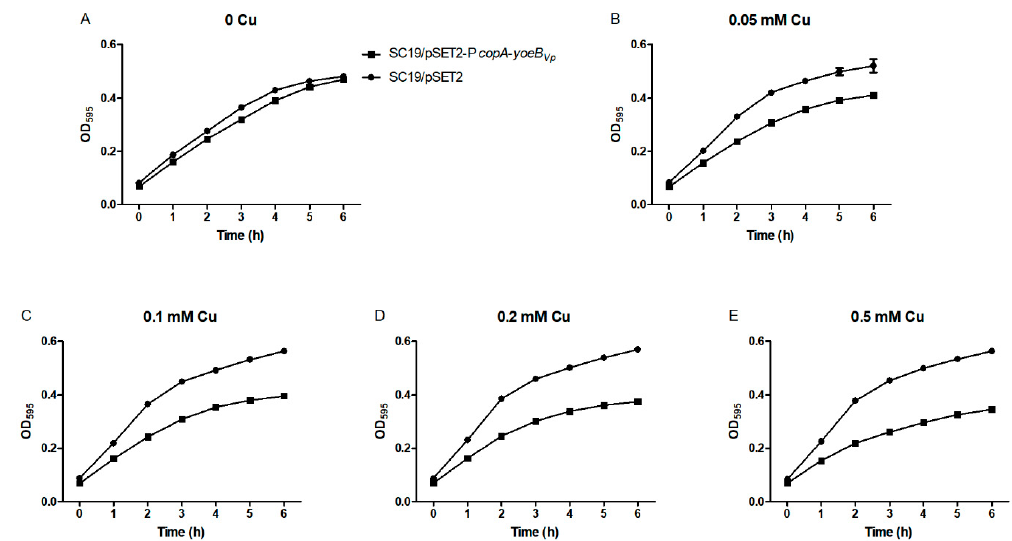
Figure 2. YoeB Vp expression resulted in a growth defect in S. suis in liquid media. The SC19/pSET2-P copA - yoeB Vp and SC19/pSET2 strains were grown in the absence ( A ) and presence of various concentrations of CuSO 4 ( B – E ); ( B ) 0.05 mM CuSO 4 ; ( C ) 0.1 mM CuSO 4 ; ( D ) 0.2 mM CuSO 4 ; ( E ) 0.5 mM CuSO 4 . At least three independent experiments were performed; the data shown are the means ± SDs from three wells in a representative experiment.